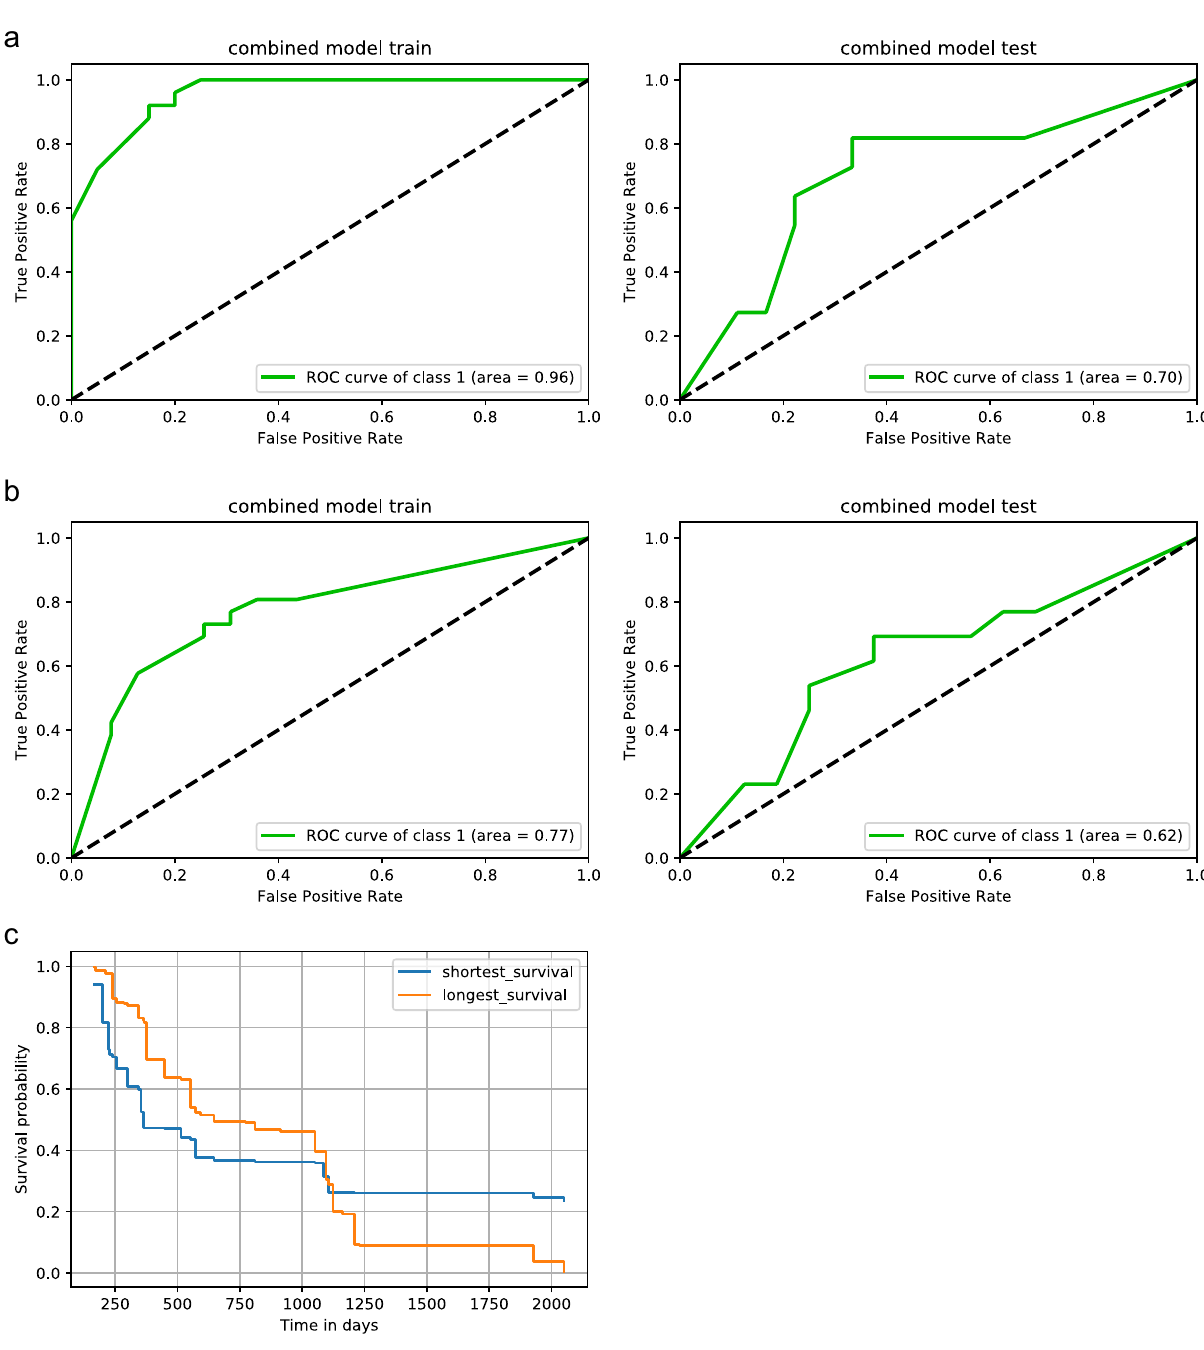
Figure 3. Prediction of response and overall survival. ( a , b ) Receiver operating characteristics (ROC) curves trained and tested using the final combined feature set of the radiomics feature LargeDependenceHighGrayLevelEmphasis and the clinical score mHAP_II_score_group. ( a ) Lesion-wise prediction with class 1 describing the individual responding lesions according to mRECIST. ( b ) Patient-wise prediction with class 1 describing the overall response on the patient-level according to mRECIST, including the impact of non-target lesions and potential new-lesions. ( c ) Patient-wise overall survival prediction. Kaplan– Meier plot of two test-patients who showed the shortest (102 days) or longest (censored at 2043 days) survival. Kaplan–Meier estimator was based on our final model. Logrank-Test was